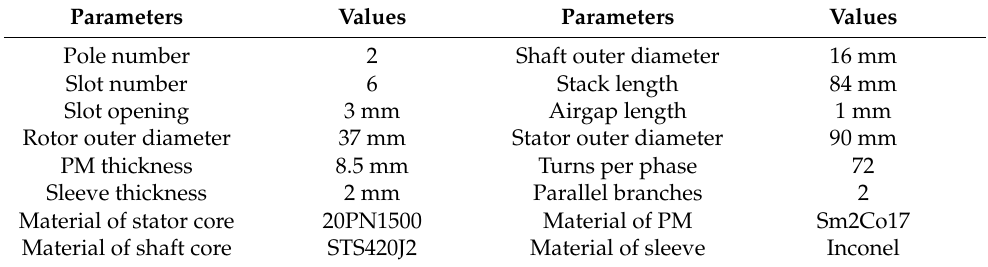
Table 1. Specifications of the HPMSM.